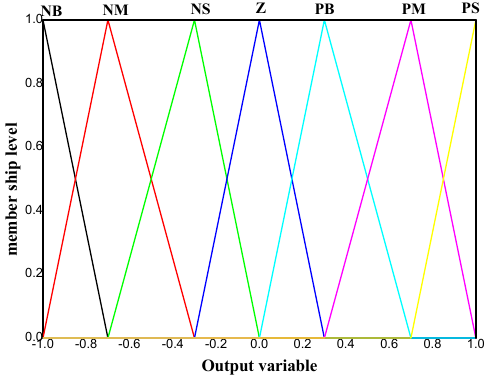
Figure 7. Fuzzy sets of the outputs.